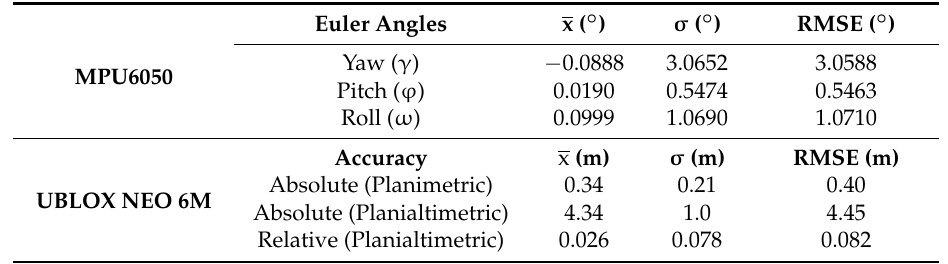
Table 5. Summary of the results for the navigation sensors: (1) Mean (x), Standard deviation ( σ ) and RMSE of discrepancies between MPU6050 and the reference data with a noise filter for yaw, pitch and roll angles and (2) x, σ and RMSE of discrepancies between UBLOX NEO 6M and the reference data in the absolute and relative positional accuracy